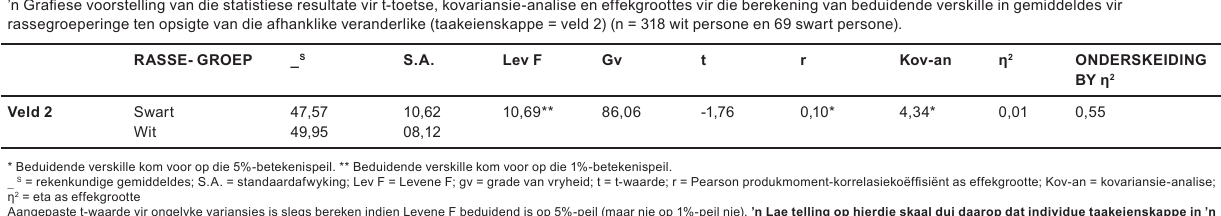
Aangepaste t-waarde vir ongelyke variansies is slegs bereken indien Levene F beduidend is op 5%-peil (maar nie op 1%-peil nie). ’n Lae telling op hierdie skaal dui daarop dat individue taakeienskappe in ’n hoë mate as stresvol ervaar, en ’n hoë telling dui daarop dat individue taakeienskappe in ’n lae mate as stresvol